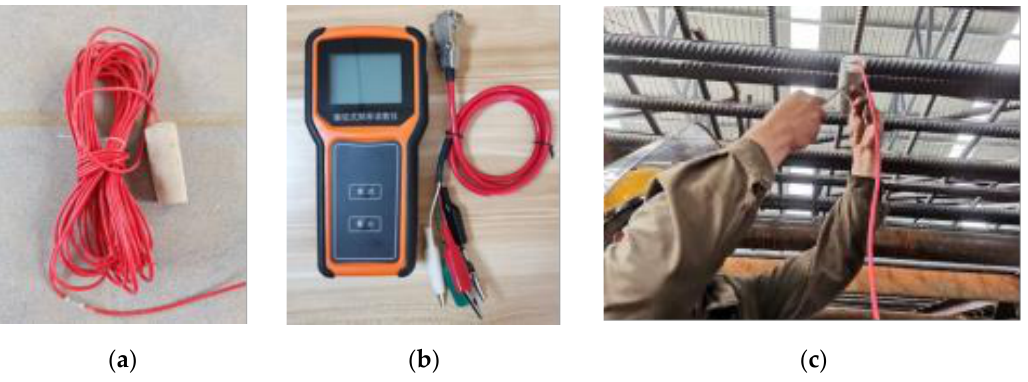
Figure 9. Instruments for circumferential stress monitoring. ( a ) Concrete strain gauge. ( b ) Frequency readout instrument. ( c ) Binding of concrete strain gauge. readout instrument. ( c ) Binding of concrete strain